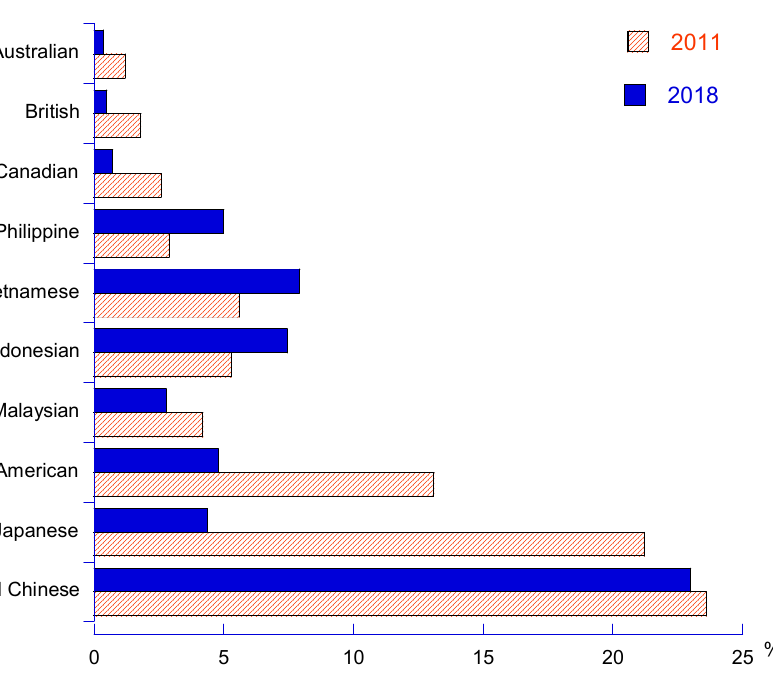
Figure 2. Major medical traveler sources in Taiwan.